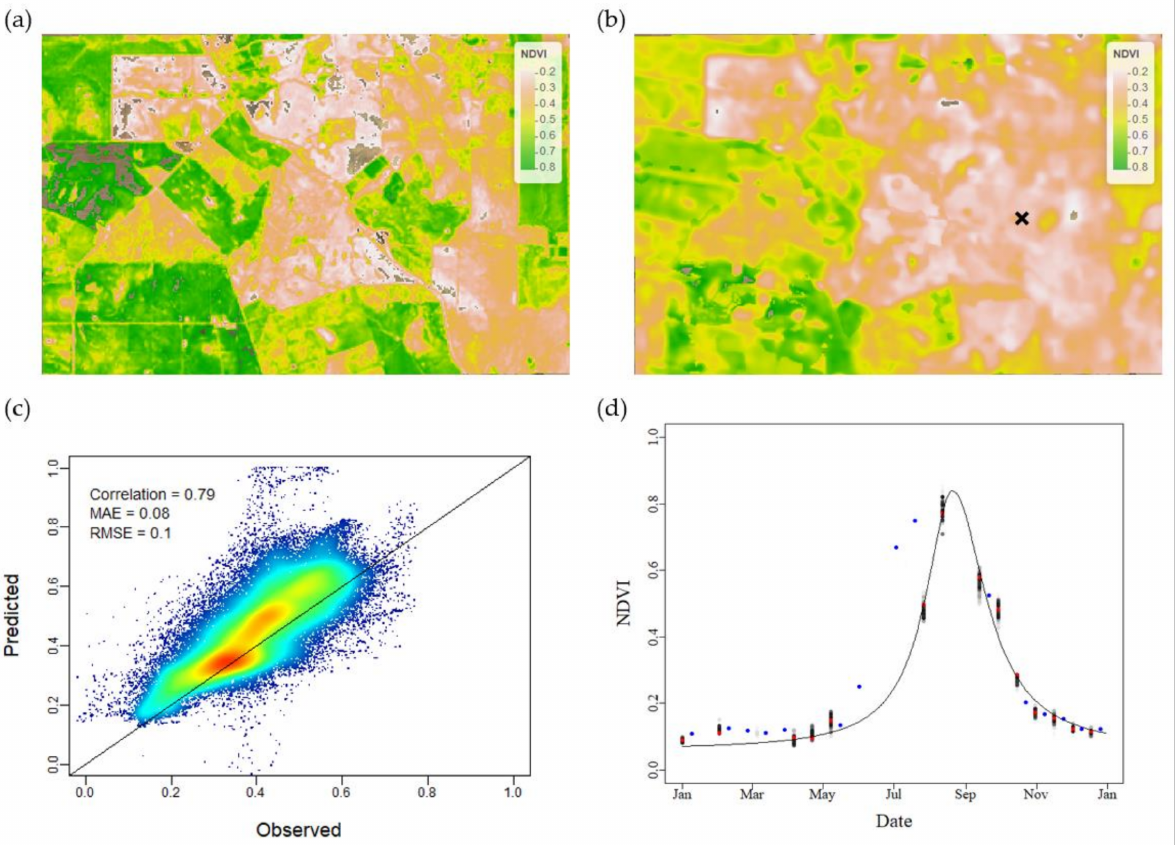
Figure 11. 2016-07-03 Landsat-8 test data: ( a ) observed NDVI; ( b ) predicted NDVI; ( c ) scatterplot of observed versus predicted NDVI coloured by density (red = high, blue = low) with overall accuracy statistics and ( d ) estimated annual growth curve for longitude 118.162, latitude − 31.268 marked by X in ( b ) with the spatially weighted Landsat-7 training data used to estimate the growth curves shown in shades of grey according to their spatial weight (white lowest and black highest, Landsat-7 data for the cell shown in red and Landsat-8 test data shown in